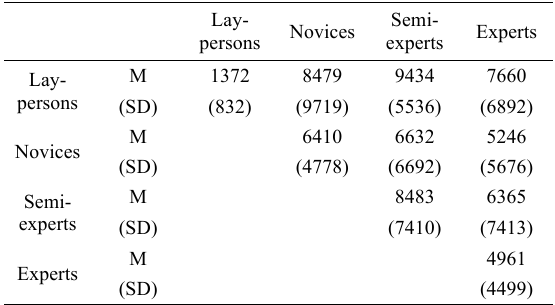
Table 5. Mean values and standard deviations of the distances between the expert groups in the sculpture